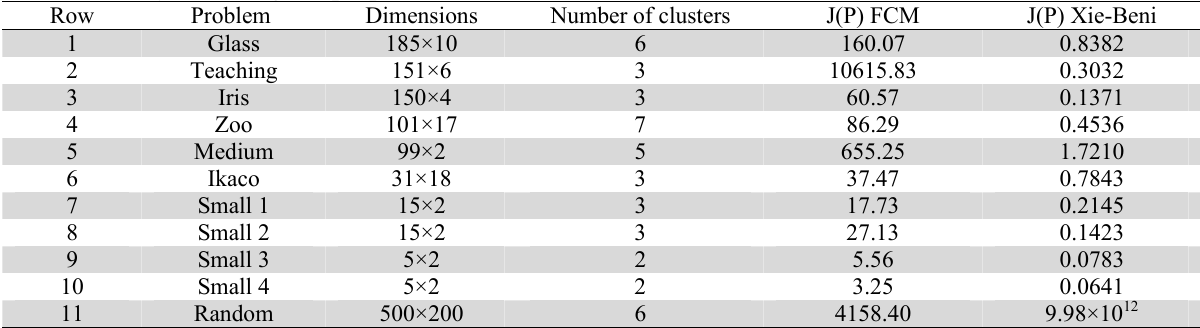
The summary of testing the proposed method based on FCM and Xie-Beni for different instances